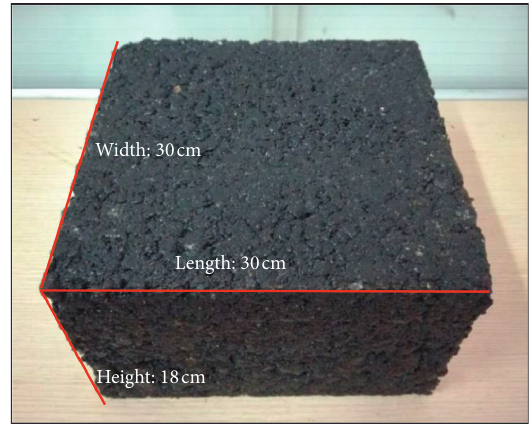
Figure 5: Internal temperature test of 18 cm thick slab